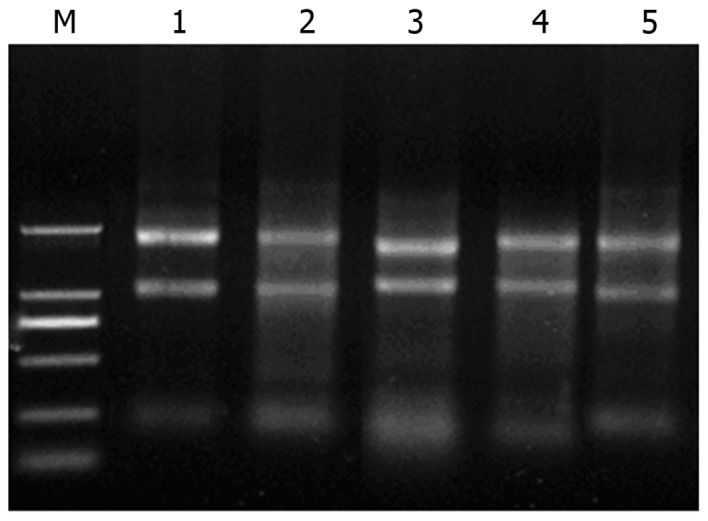
SDS-PAGE for total RNA analysis. Lanes from left to right: M, DL2000 Marker; 1, Huh7; 2, SMMC7721; 3, HepG2; 4, Bel-7402; and 5, HL-7702 cells. In each electrophoresis lane, three bands are observed, with sedimentation coefficients of ribosomal RNA of s=28, 18 and 5, demostrating the high integrity of total RNA.